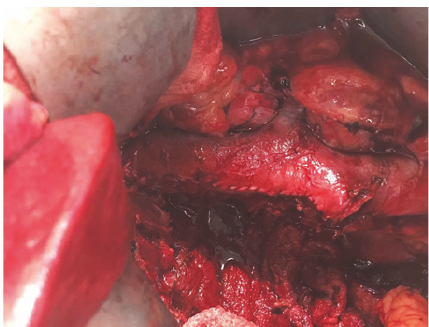
Figure 6: Radical Nephrectomy with complete IVC thrombectomy and caval reconstruction.